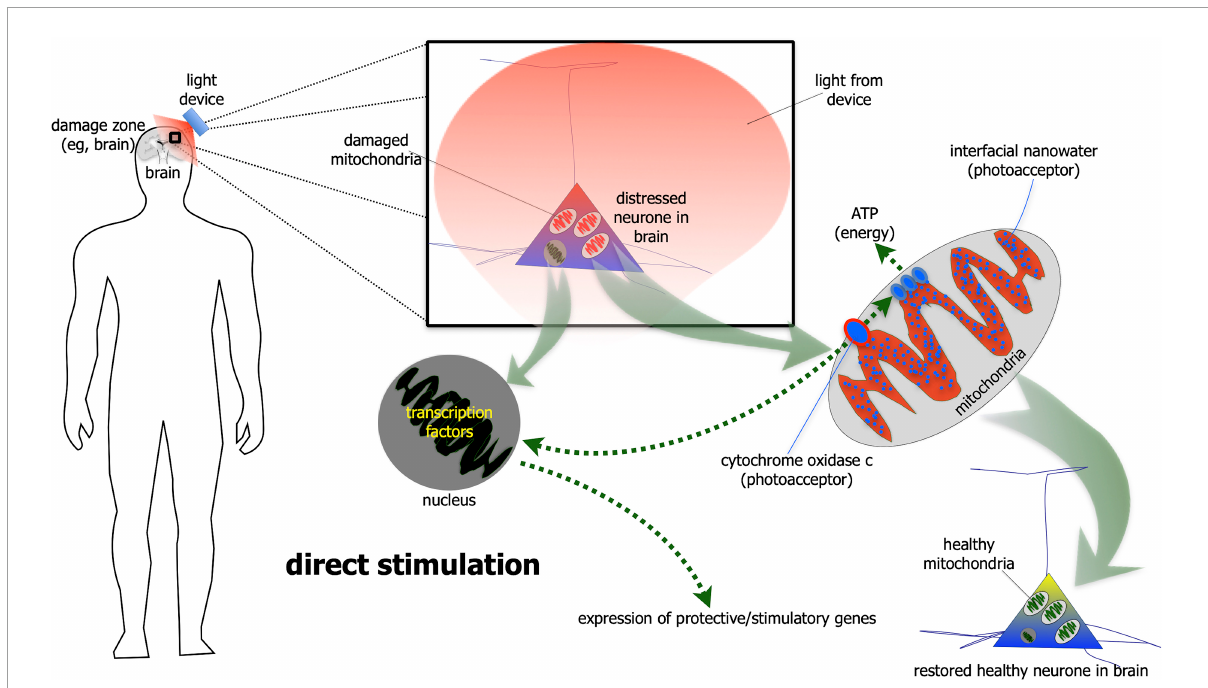
FIGURE1 Schematic diagram showing the direct stimulation mechanism of photobiomodulation. When photobiomodulation hits the cells directly, it is absorbed by a photoacceptor, most notably cytochrome oxidase c or interfacial nanowater within the mitochondria. This results in the production of more ATP (adenosine triphosphate) energy and to the activation of transcription factors in the nucleus and expression of protective and stimulatory genes within the cells. The net result is a healthier